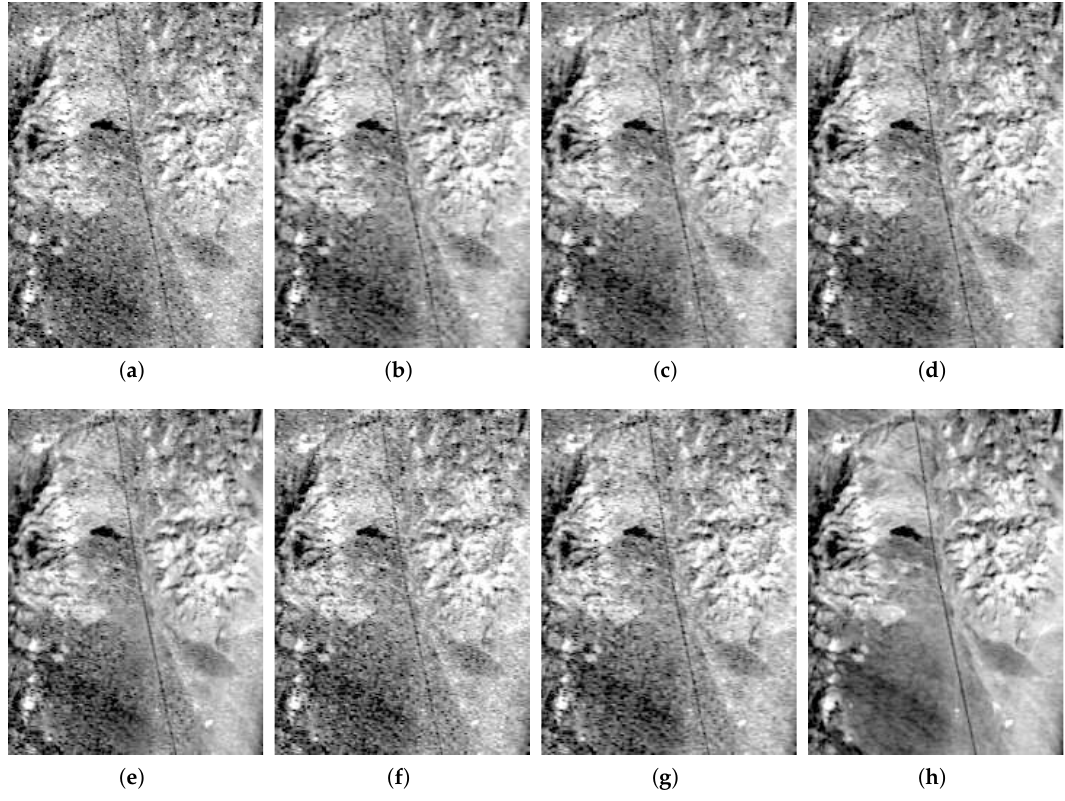
Figure 12. Denoising results for band 37 (2365.2 nm) of the Hyperion hyperspectral image at Cuprite Mining District: ( a ) original; ( b ) BM3D (16 s); ( c ) BM4D (69 s); (d) PCA + BM4D (58 s); ( e ) LRMR (21 s); ( f ) NAILRMA (46 s); ( g ) FastHyDe(un) ( 11 s ); ( h ) HyDRoS (34